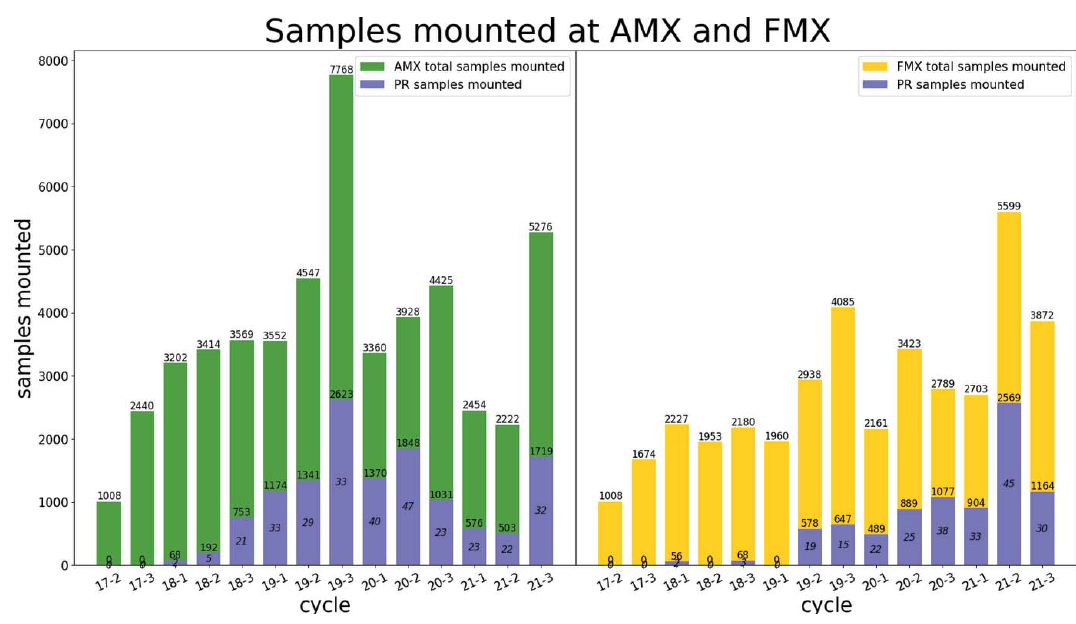
Figure 10 Sample throughput at the AMX and FMX beamlines. Total number of samples mounted at each of the two MX beamlines at the NSLS-II including samples from proprietary users. Sample throughput in calendar year 2020 is lower than expected due to the effect of the pandemic. Nevertheless, the AMX and FMX beamlines remained in operation to support ongoing efforts to deal with the pandemic including inhouse research on the main protease, the receptor binding domain of the spike protein and a peptide preventing fusion of the SARS-CoV-2 with the host cell